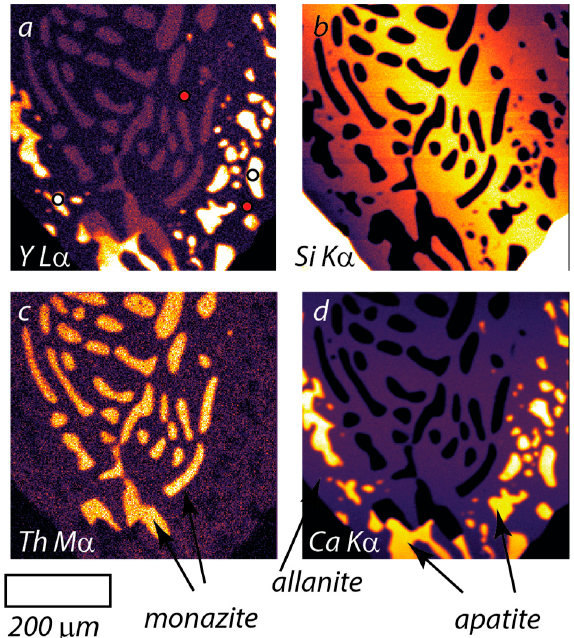
Figure 4. Close up WDS maps of Type II monazite showing relict zoning and intergrown apatite, allanite, and monazite. X-ray line labeled in lower left of each image ( a – d ).